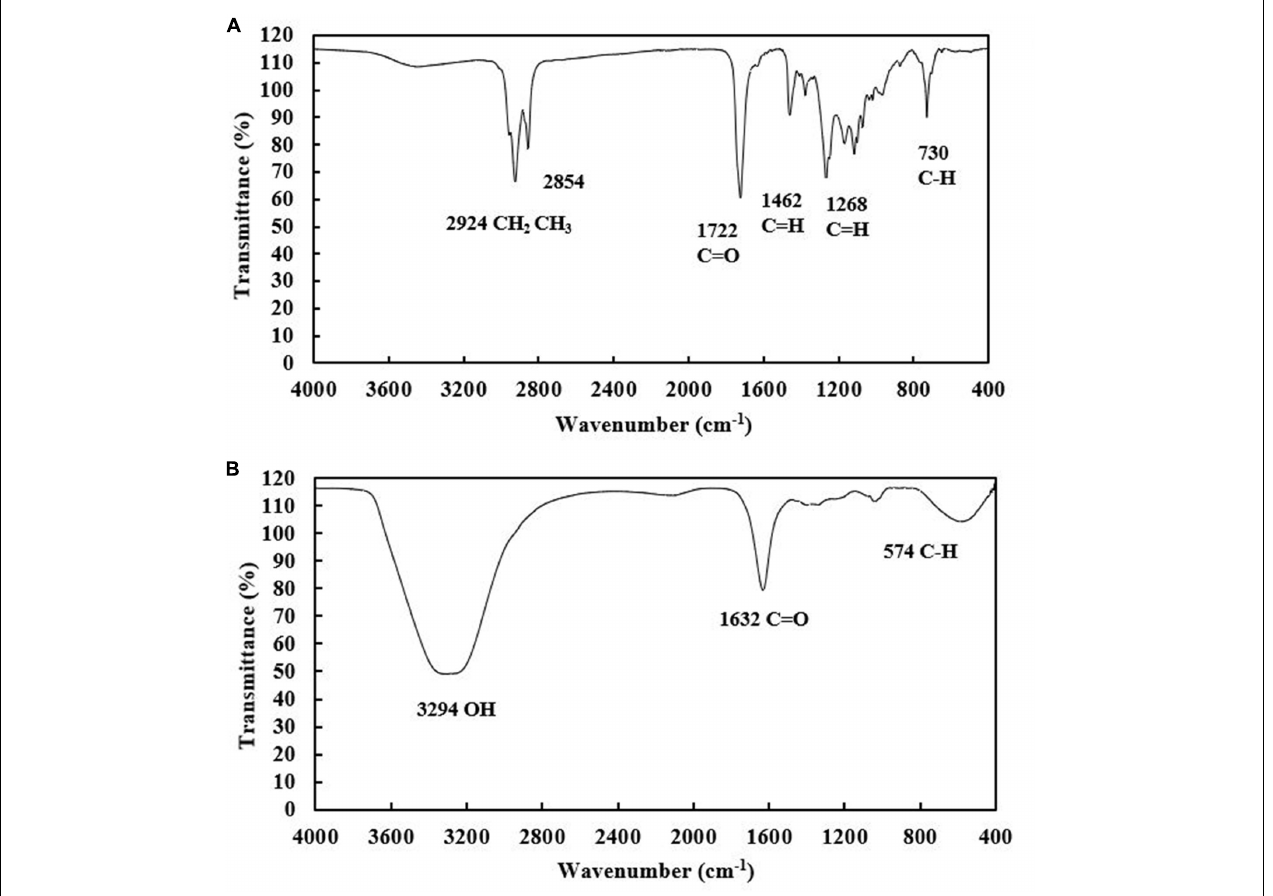
FIGURE 6 | FTIR spectra of purified extracellular (A) and cell-bound biosurfactants (B) from Weissella cibaria